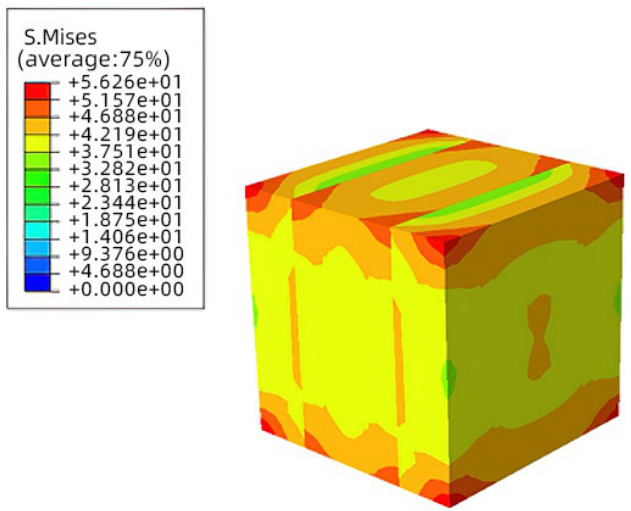
Figure 19. Stress cloud diagram of the specimen subjected to Y-axis loaded compression.